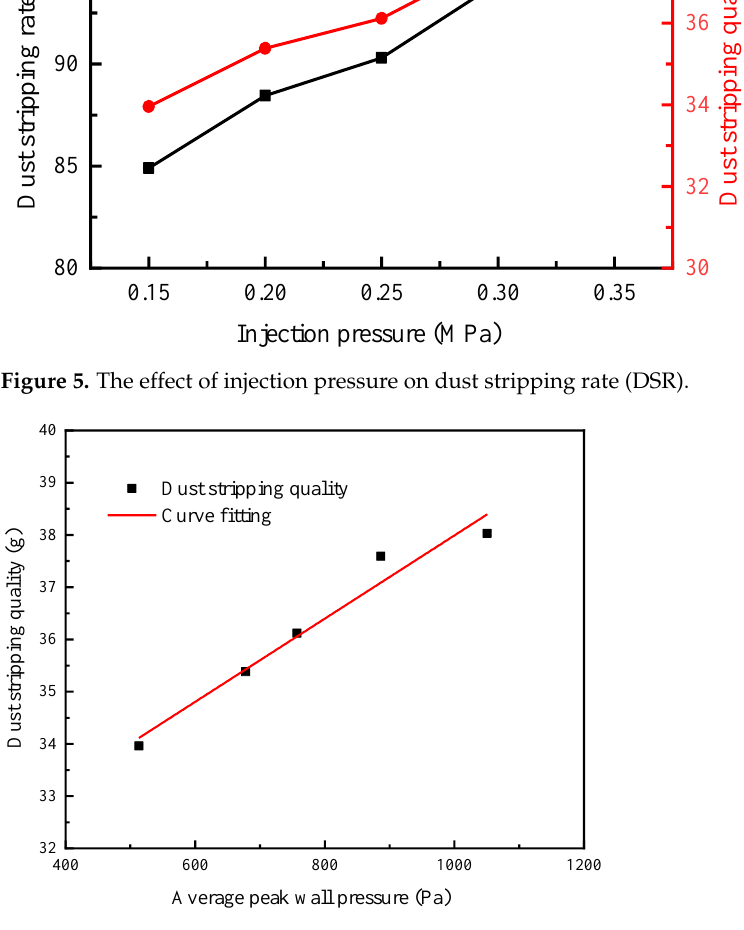
Figure 6. The relationship between the average wall surface peak pressure (AWSPP) and dust stripping quality.